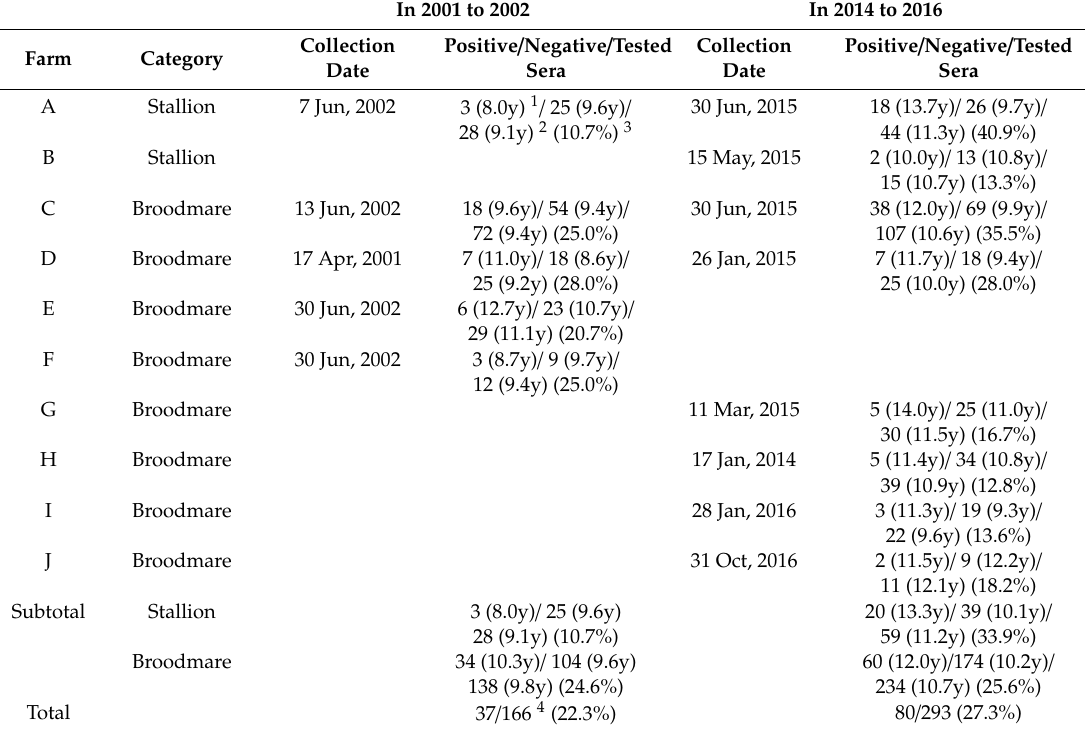
Table 5. Prevalence of EFV antibody in horses in Hokkaido in